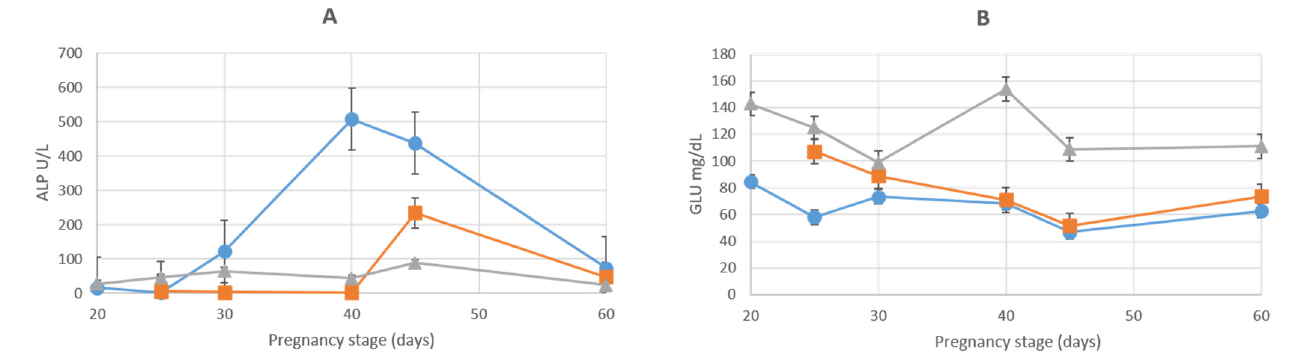
Figure 8. Graphic representation of ALP ( A ) and GLU ( B ) concentrations during pregnancy in maternal serum (marked with (cid:78) ), amniotic fluid (marked with • ) and allantoic fluid (marked with ■ ). Values are indicated as mean ± SE.